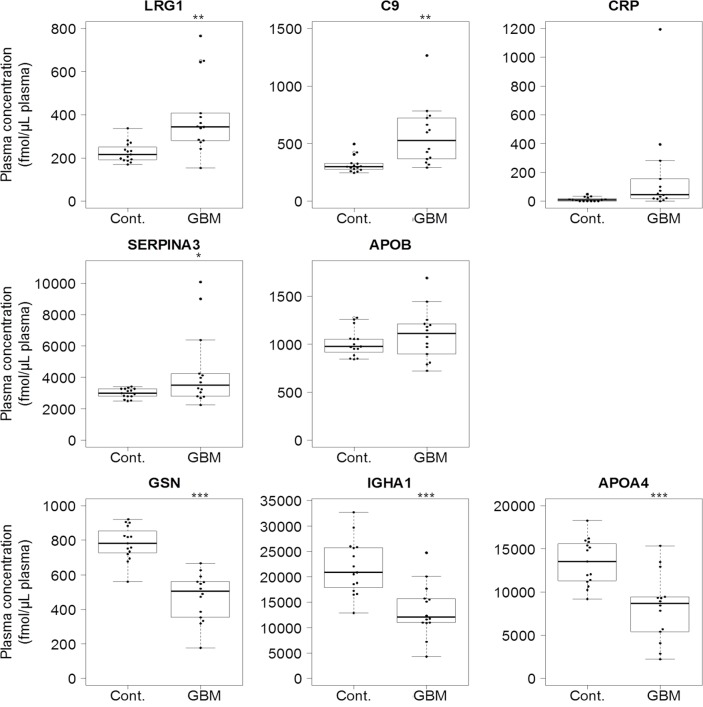
Box plot showing the plasma levels of each differentially expressed protein in GBM plasma (n = 14) compared with healthy plasma (n = 15).Each dot represents the protein level of an individual sample. In box plots, the band inside the box represents the median. The bottom and top of the box represent the first and third quartiles. The whiskers reflect the minimum and maximum values that fall within 1.5 times the interquartile range. Any data not included between the whiskers is an outlier. *, p < 0.05; **, p < 0.01; ***, p < 0.001. Cont, Healthy controls; GBM, glioblastoma.